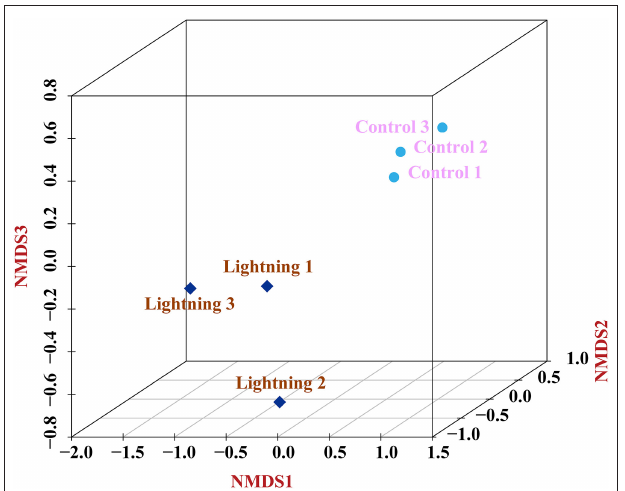
FIGURE 8 | Variations of bacterial communities among different samples based on Nonmetric Multidimensional Scaling (NMDS) analysis. Lighting represents a sample 10m from the lightning rod; Control indicates that the distance between the sample and the lightning rod is > 1,500m.